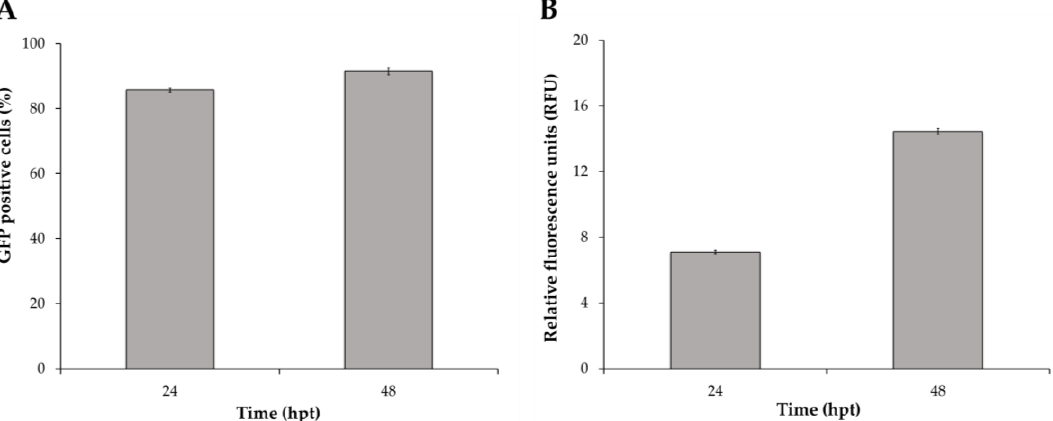
Figure 3. Validation experiment at the optimal conditions determined by the combination of DoE and desirability functions. ( A ) Monitoring of HEK293 cell transduction efficiency by flow cytometry, and ( B ) VLP production by spectrofluorometry up to 48 hpt. The mean and standard deviation of triplicate experiments are represented. hpt: hours post transduction.